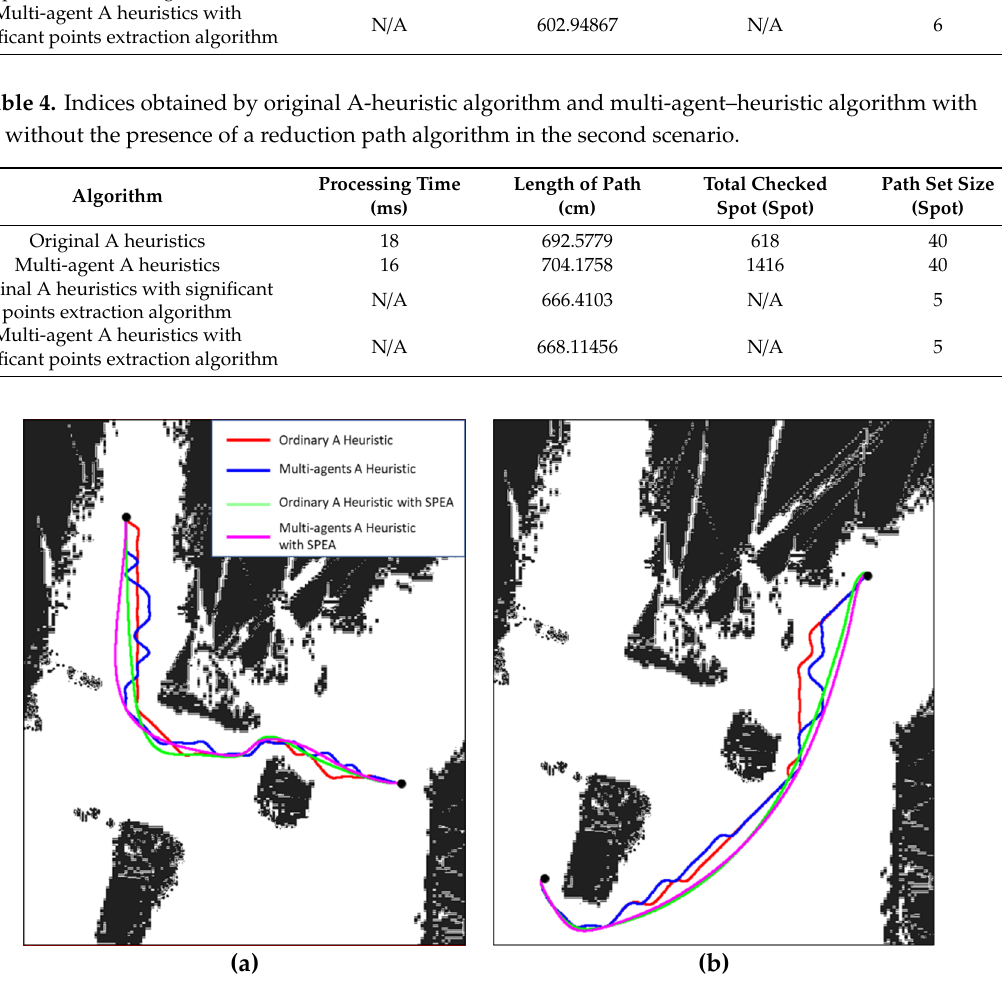
Table 4. Indices obtained by original A-heuristic algorithm and multi-agent–heuristic algorithm with or without the presence of a reduction path algorithm in the second scenario.